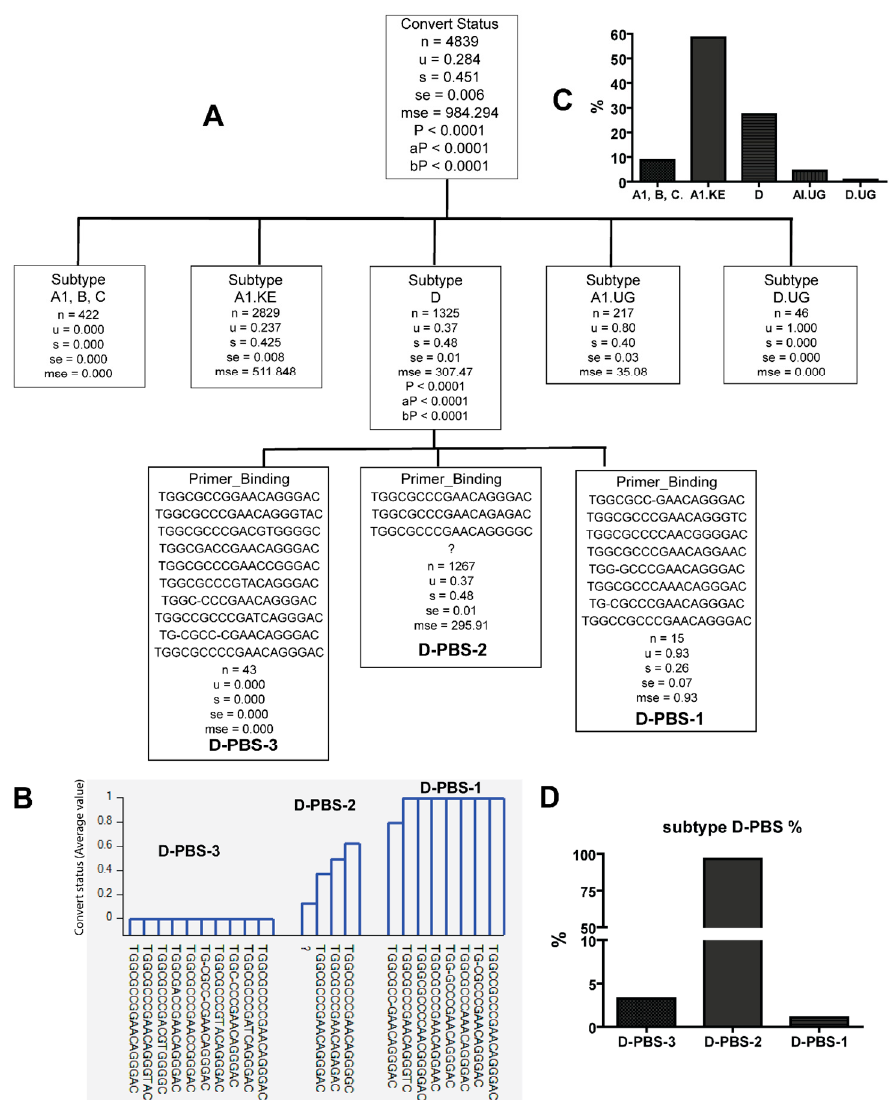
Figure 9. The combination of HIV subtype D and primer binding sequences (PBS) identified only in either late ( u = 1) or early seroconverters ( u = 0). ( A ) HIV subtype D in tree node of subtype D was further classified with PBS sequence variants, based on whether they were identified from late or early seroconverters. ( B ) The figure shows u value of sequence combinations based on whether the subtype D–PBS combinations were identified from late (1) or early (0) seroconverters. Note: n— counts (clone); u —mean value; s—standard deviation; se—standard error; mse—mean square error; p—p value; aP—adjusted p value; bP—Bonferroni corrected p value; “?” denotes the lack of sequence. ( C ) HIV subtype frequency. ( D ) Subtype D–PBS frequencies in subtype D.